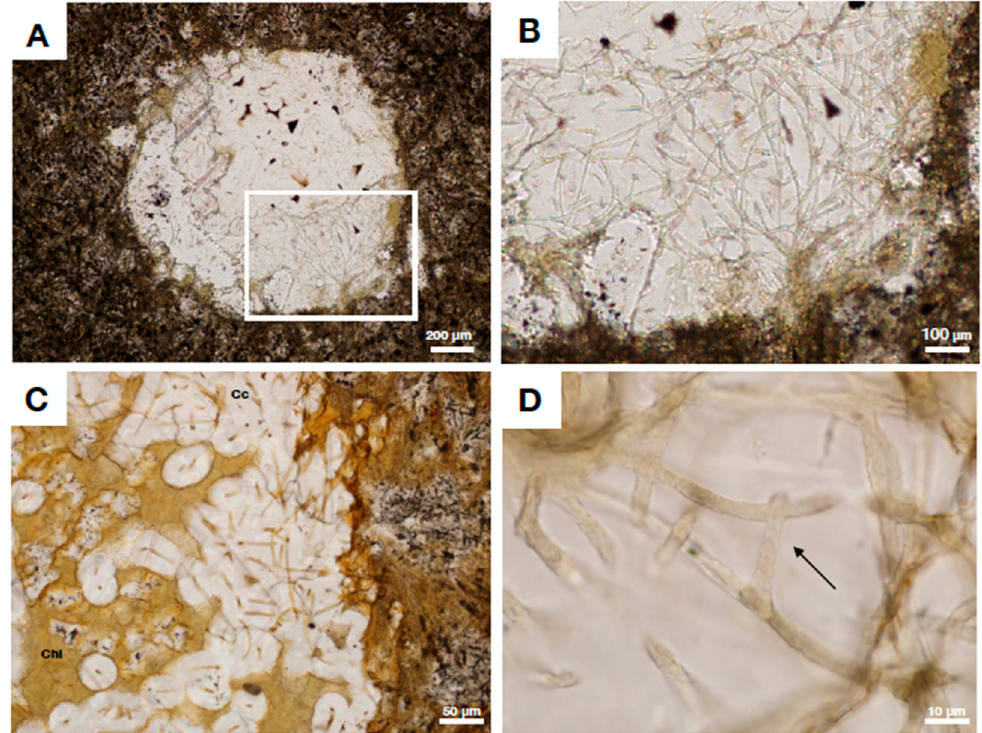
Figure 1. Optical micrographs of basalt from the Ongeluk formation, South Africa, showing a vesicle with extensive fungal-like mycelia consisting of chlorite. ( A ) Vesicle in basalt matrix with fungal chloritized hyphae surrounded by secondary infilled calcite. Boxed area is enlarged in ( B ). Scale bar equals 200 µ m (B) Enlarged area from (A) showing dense fungal-like mycelia protruding from the walls into a vesicle. Filaments consist of chlorite and are enclosed in calcite. Scale bar is 100 µ m. ( C ) Detail of chloritic fungal hyphae surrounded by calcite. Chlorite is yellow, calcite white. Scale bar equals 50 µ m. ( D ) Chlorite filaments with even diameters show fungal like characteristics such as potential anastomosis (arrow). Scale bar equals 10 μ m.